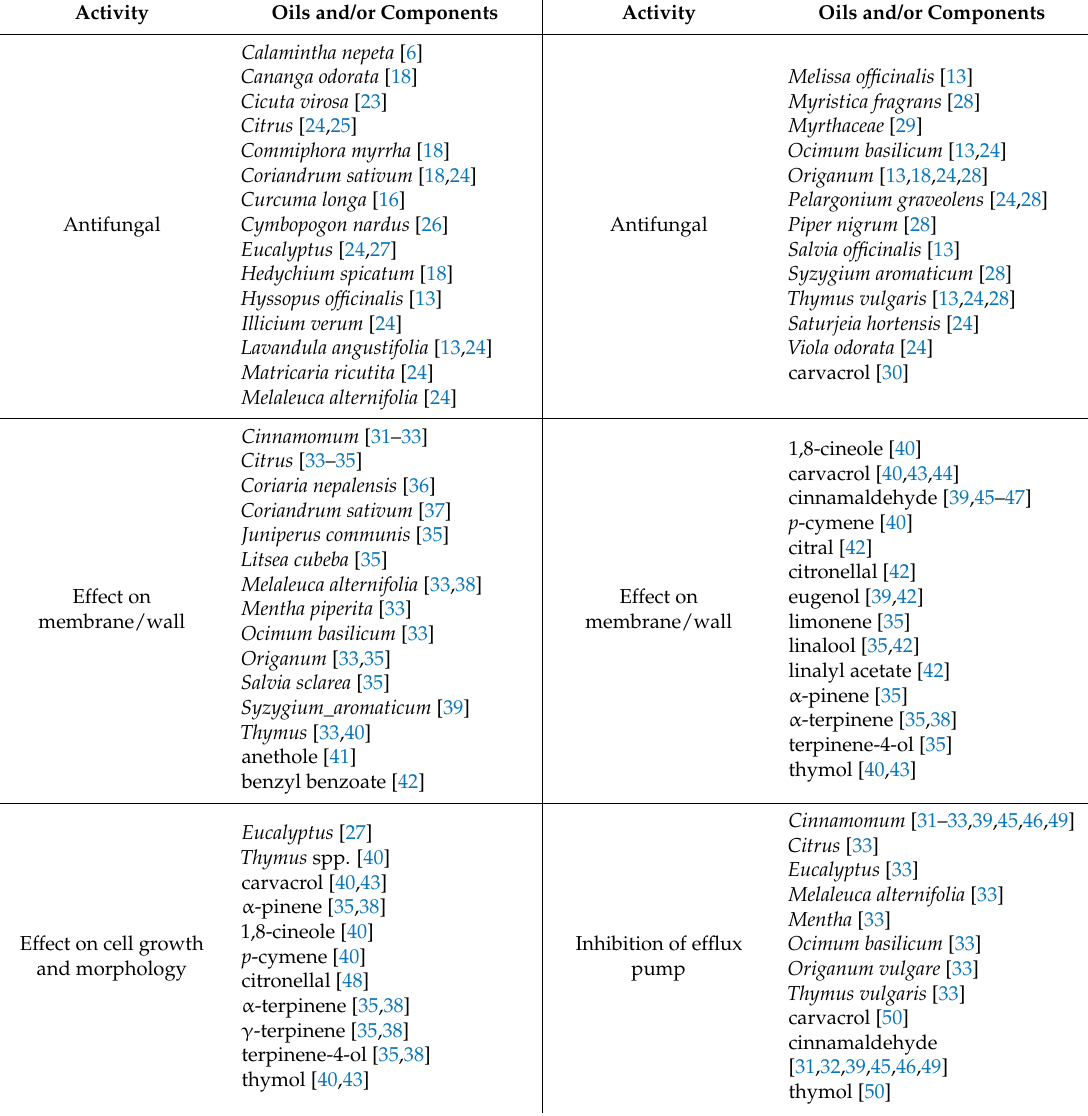
Table 1. Principal effects of essential oils and/or their components on fungi. References are indicated in